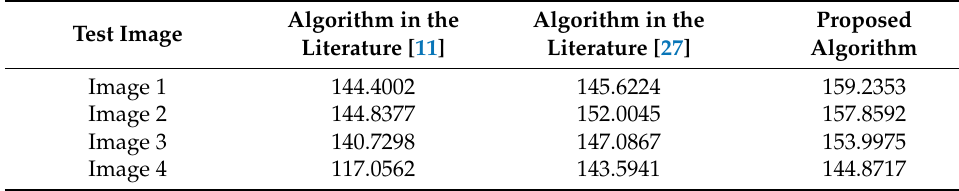
Table 7. Final results of total PSNR. Test